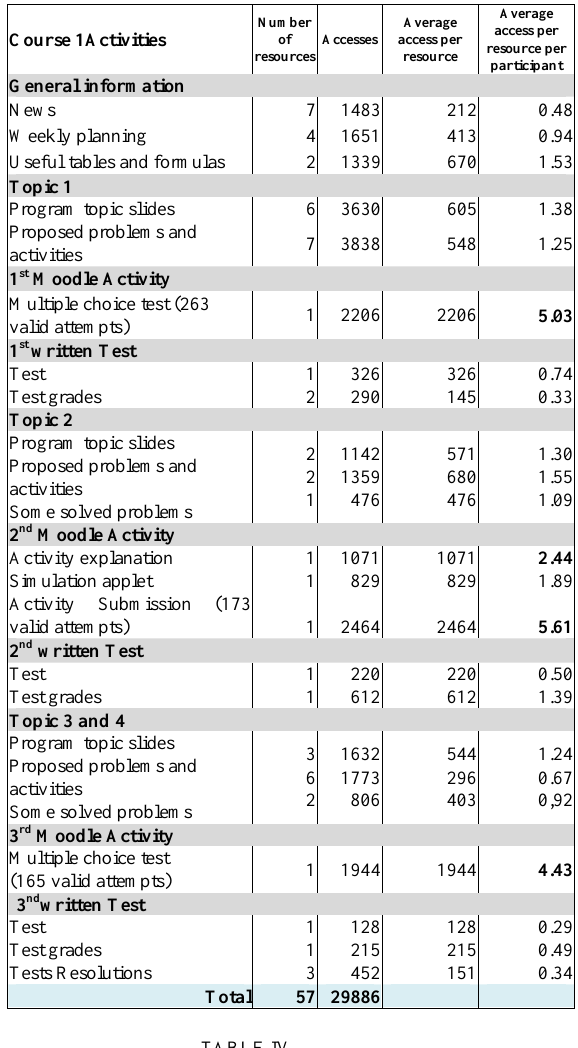
TABLE IV. M OODLE C OURSE 2 ACESSES PER RESOURCE AND